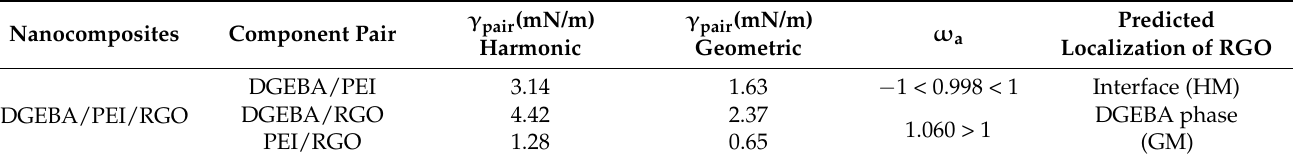
Table 1. The interfacial tension ( γ pair ) and ω a were obtained by different methods. γ pair (mN/m) Nanocomposites Component Pair